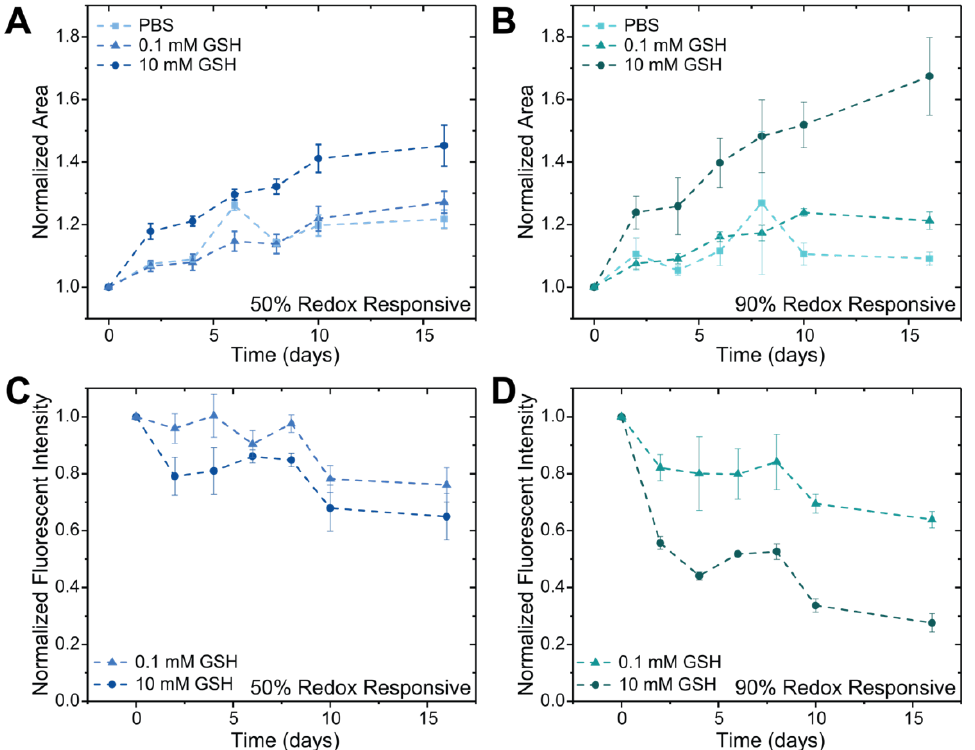
Figure 5. Characterization of microgels degraded in aqueous or reducing conditions . The area of the microgels, determined using the circular area of microgel confocal projections, at each time point was determined for microgels containing either 50% ( A ) or 90% ( B ) redox-degradable crosslinks for a period of 16 days as a measure of microgel degradation. To assess release of dextran-TRITC from the degraded 50% ( C ) and 90% ( D ) formulations, the fluorescent intensity inside the microgels was determined and normalized to microgels incubated in PBS to account for potential photobleaching of the TRITC group over time.